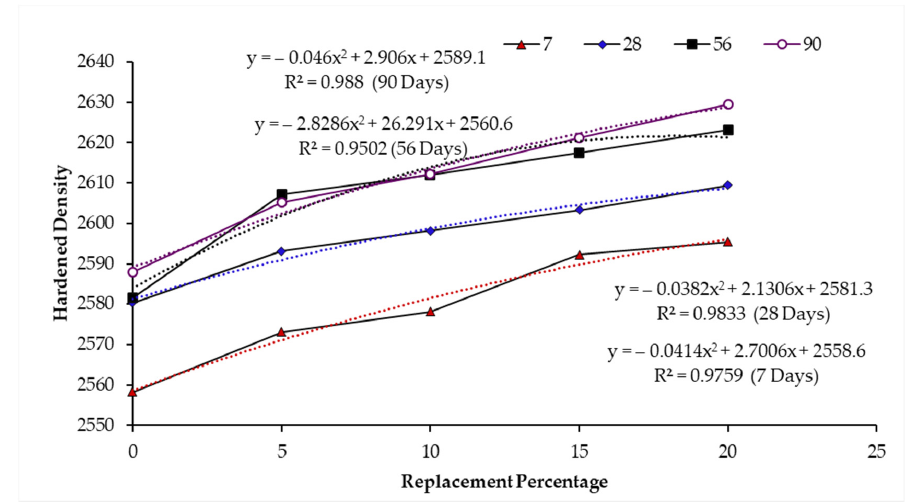
Figure 11. Regression correlation between hardened density and WSA content at various curing ages.